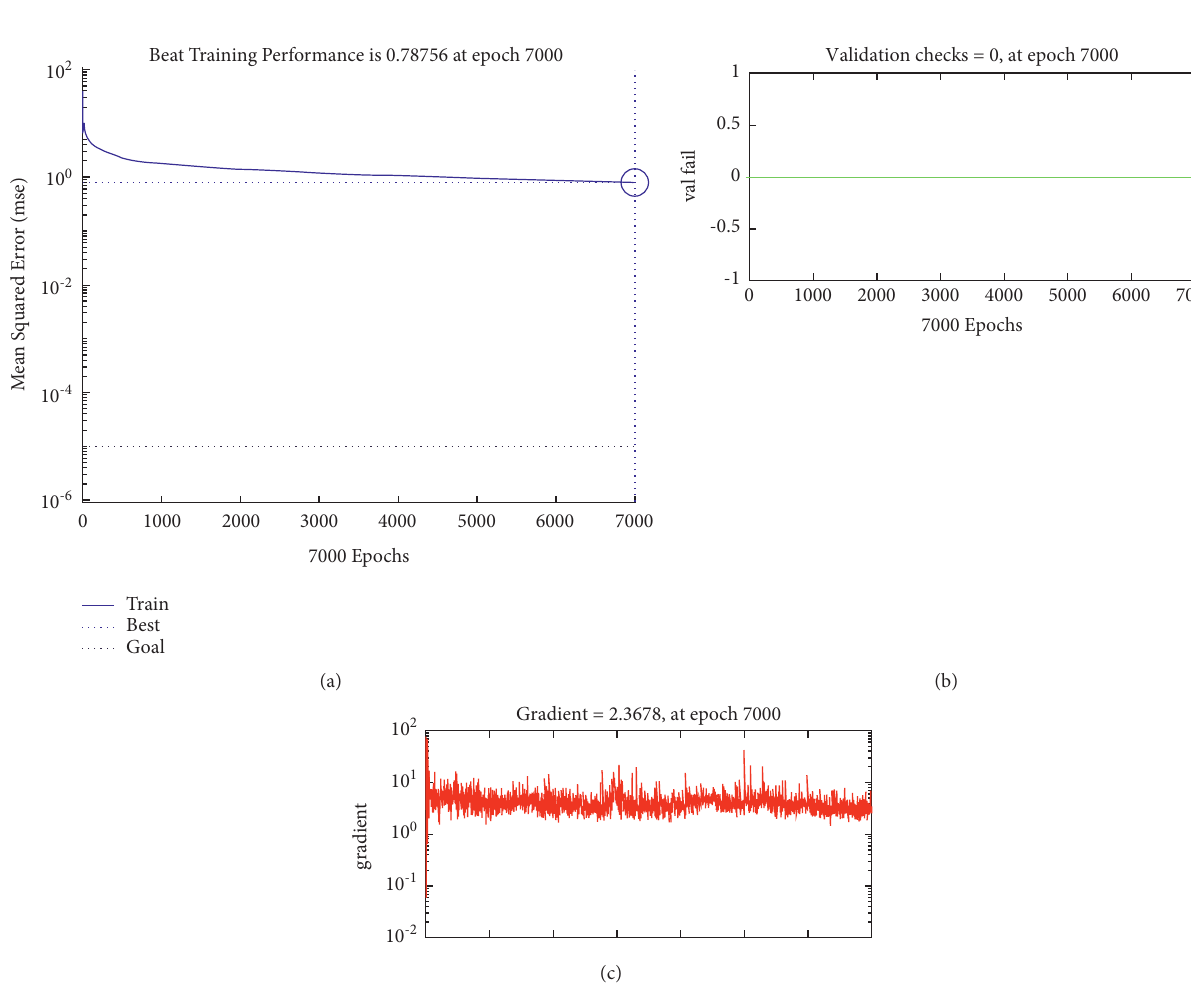
Figure 5: Results of the DINN method for performance prediction. (a) Error value in the training process, (b) failure value in the training process, and (c) the value of the gradient of the target and model